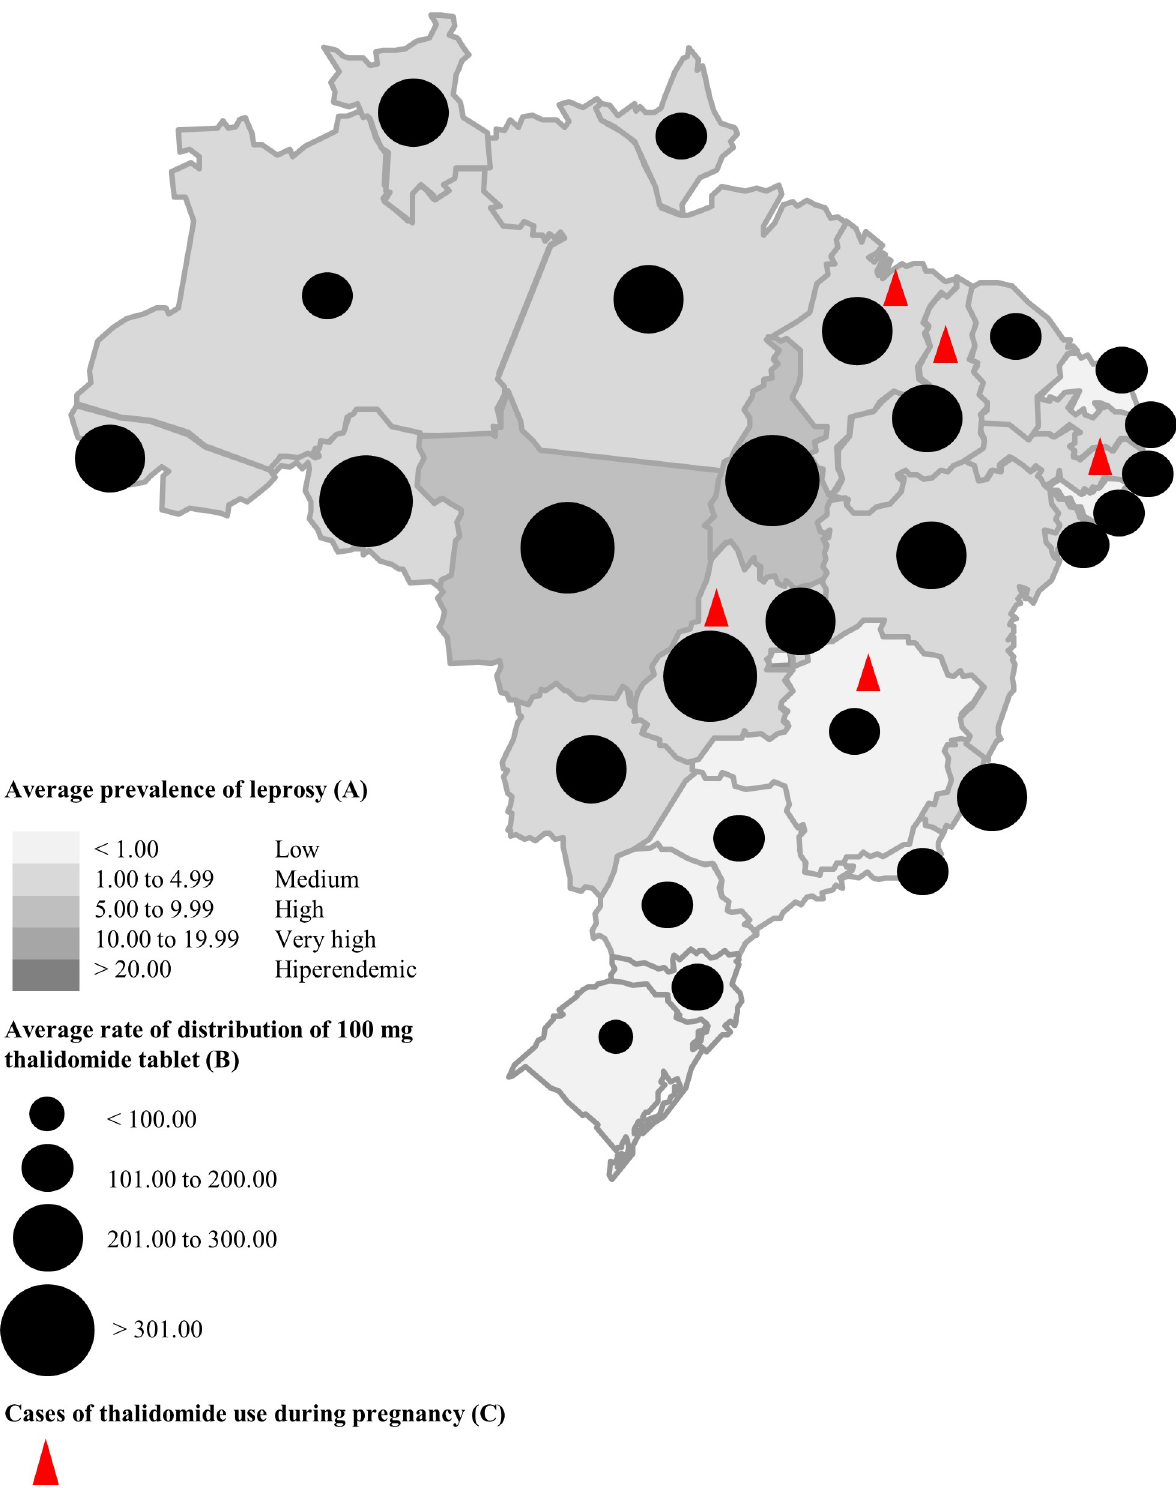
Fig 6. Average prevalence of leprosy, average rate of distribution of 100 mg thalidomide tablet, and reported cases of thalidomide use during pregnancy in Brazil between 2011 and 2018. (A) Average number of leprosy cases in the state between 2011 and 2018/average total population in the state between 2011 and 2018 per 10,000 inhabitants. (B) Average number of 100 mg thalidomide tablets in the state between 2011 and 2018/ average total population in the state between 2011 and 2018 per 10,000 inhabitants [58,59,63].